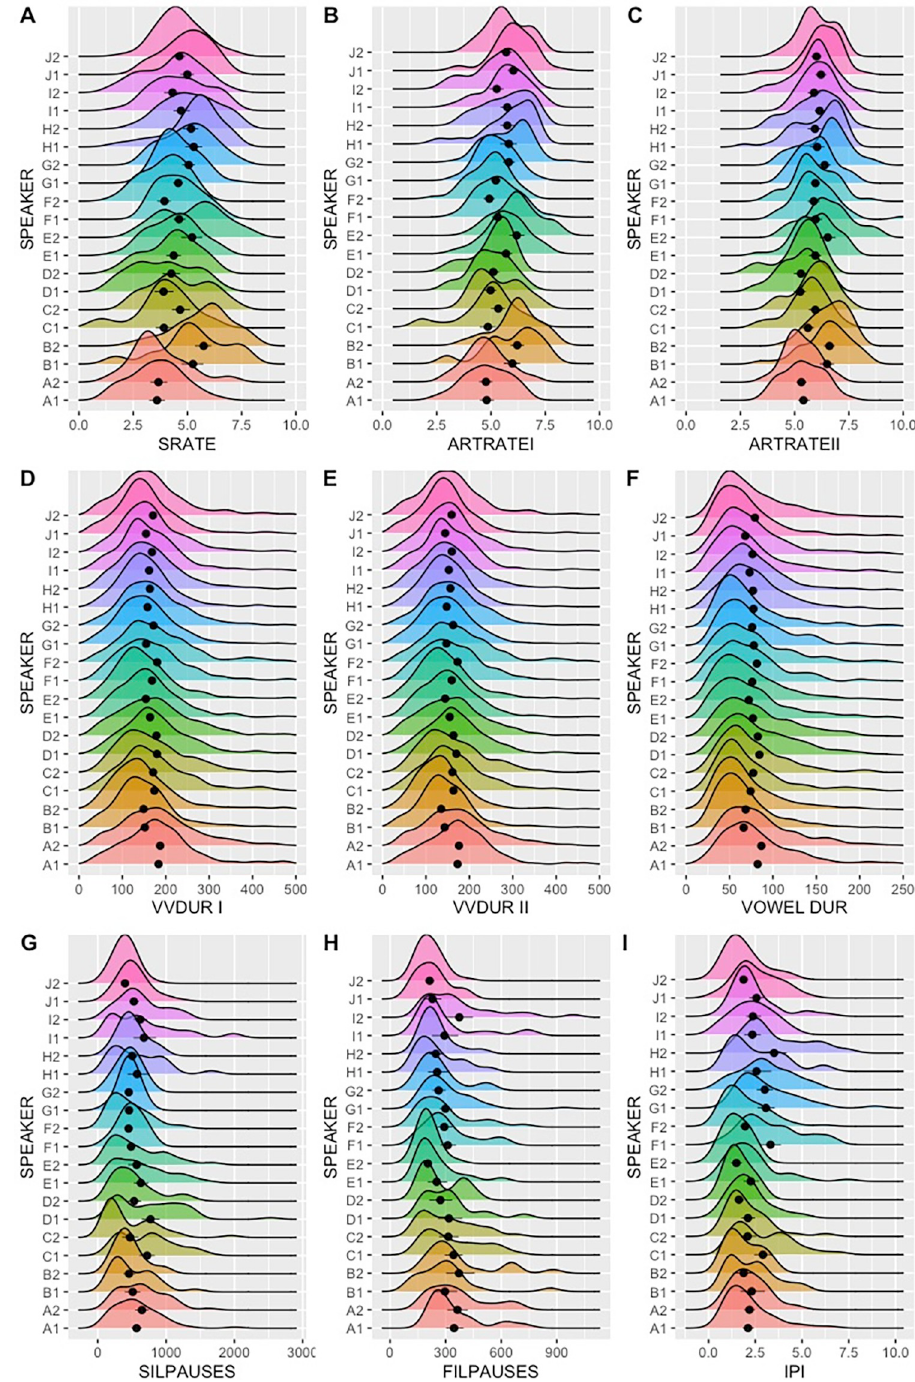
Fig 2. Diagram of density for speech rate (A), articulation rate I (B), articulation rate II (C), V-V unit duration I (D), V-V unit duration II (E), Vowel duration (F), silent pauses (G), filled pauses (H), IPI (I).